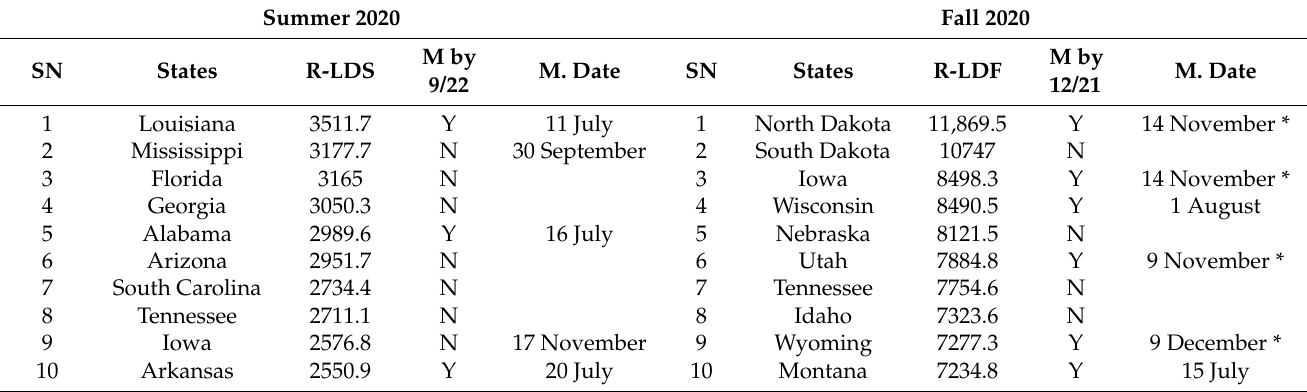
Table 3. Highest summer and fall rates of confirmed COVID-19 infection